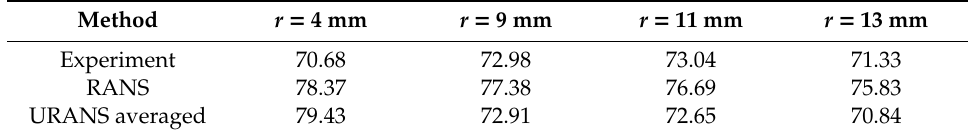
Figure 7. Time history of static pressure and its averaged value computed by unsteady Reynolds- Averaged Navier-Stokes (URANS) in comparison with those of Reynolds-Averaged Navier-Stokes (RANS) and experiment. Table 3. Experimental and numerical results of static pressure. Table 3. Experimental and numerical results of static pressure.